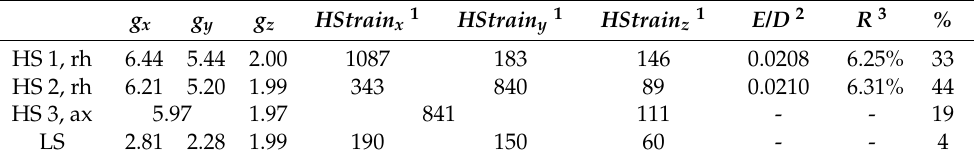
Table 1. EPR parameters for simulation of the Dictyostelium DyPA 6K spectrum.